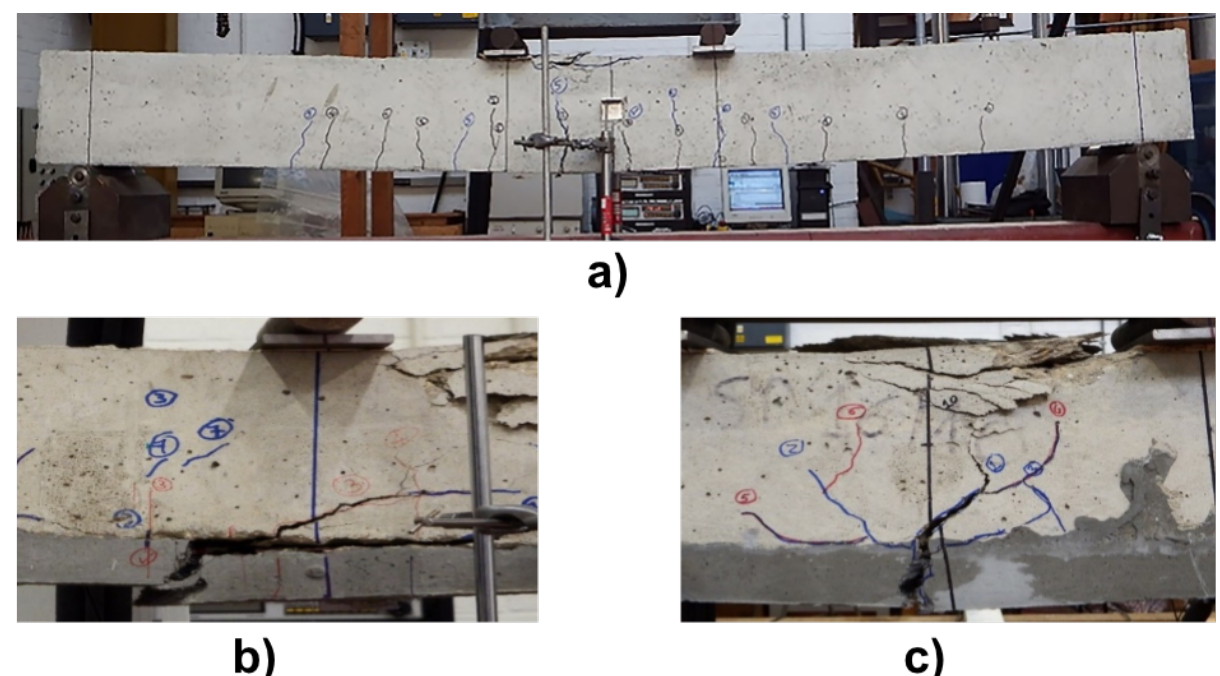
Figure 7. Results from the testing of beams.